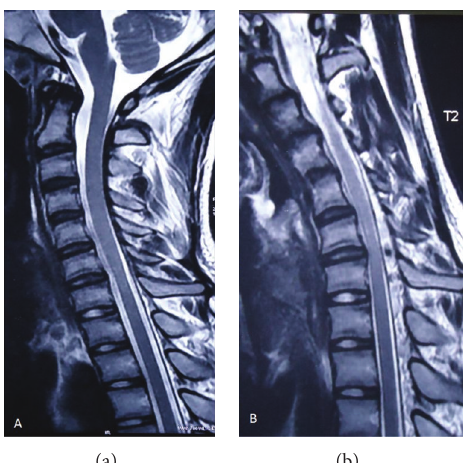
Figure 4: (a) Neutral position MRI of cervical spine T2W image reveals mild focal atrophy of cervical cord at C6-C7 levels with loss of attachment between the posterior dural sac and subjacent lamina. (b) Flexion MRI of cervical spine T2W image reveals characteristic anterior displacement of the posterior wall of cervical dural canal reaching up to spinal cord. Prominent posterior epidural spaces with multiple flow voids suggestive of prominent venous plexus are